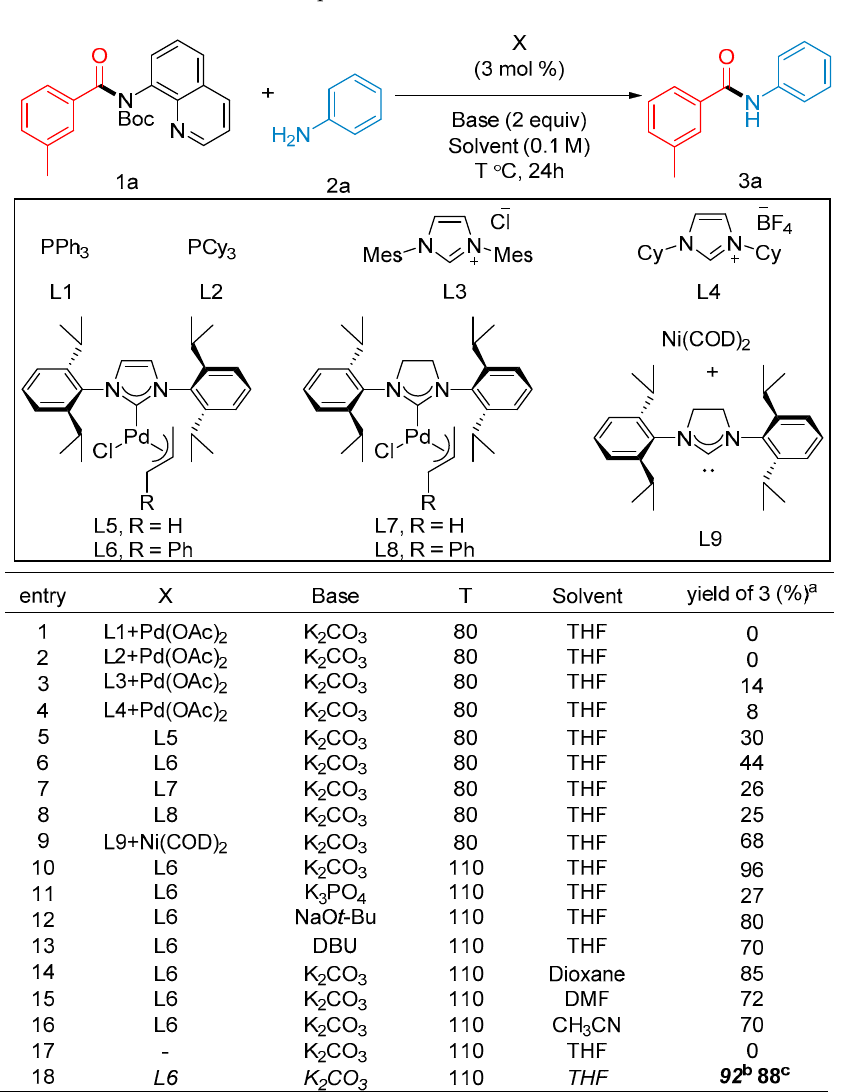
Table 1. Optimization of removal of 8-AQ. Molecules 2019 , 24 , x FOR PEER